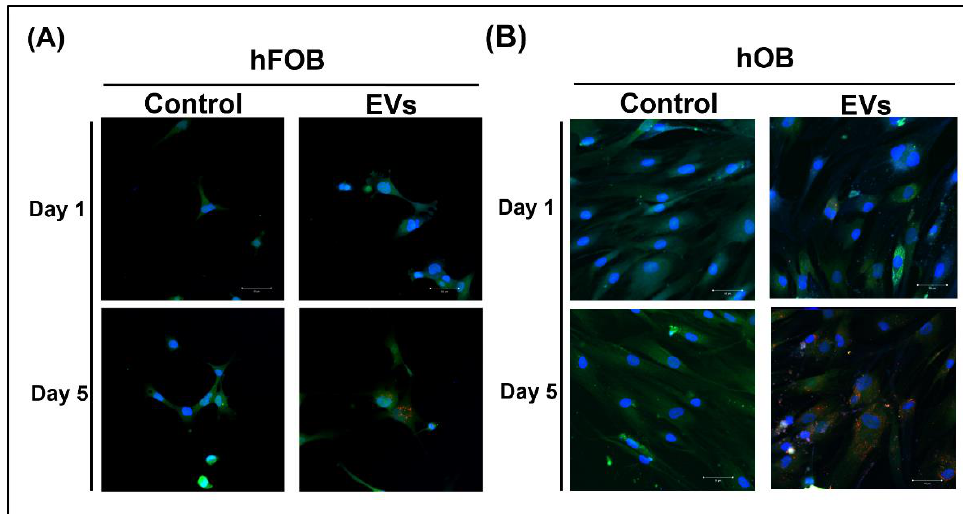
Figure 2. ADSC-EV uptake by osteoblasts. The hFOBs ( A ) and hOBs ( B ) were treated with CM-DiI- labeled ADSC-EVs at concentrations of 0 (Control: control group) or 1 × 10 9 particles/mL (EVs: EV group) for 5 days, and images at days 1 and 5 were obtained using a camera under confocal microscopy. Cell nucleus, blue fluorescence stain; cytoplasm, green fluorescence stain; and CM-DiI- labeled ADSC-EVs, red fluorescence stain.